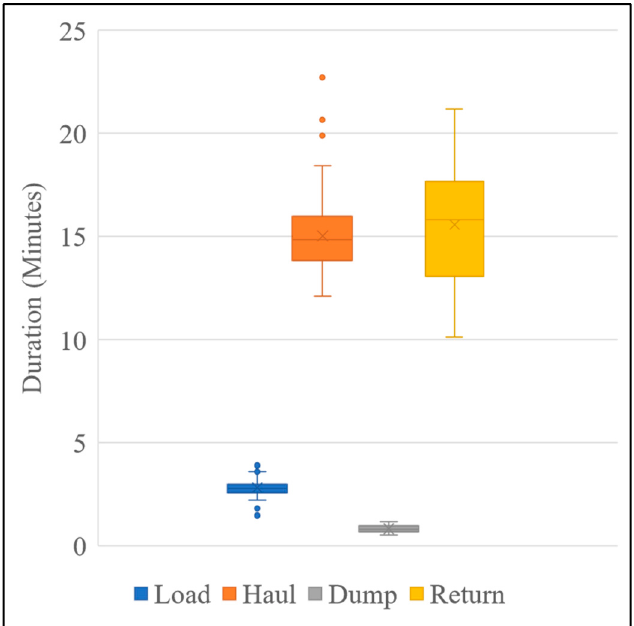
Figure 11. Cycle time durations of dump trucks.